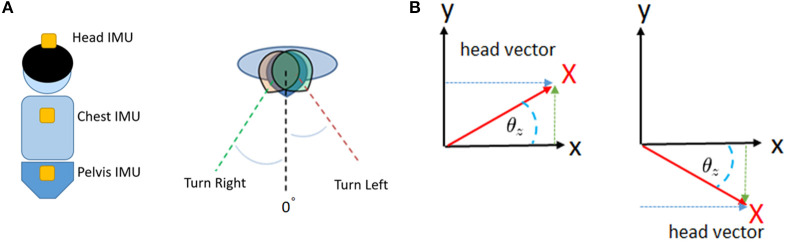
Illustration of the trunk motion analysis. Our patients wore IMUs on the head, chest, and pelvis (A). We detected and recorded the yaw rotation of these body segments during walking (B). After conversion, we were able to obtain continuous data regarding the degrees of rotation of the head, chest, and pelvis.